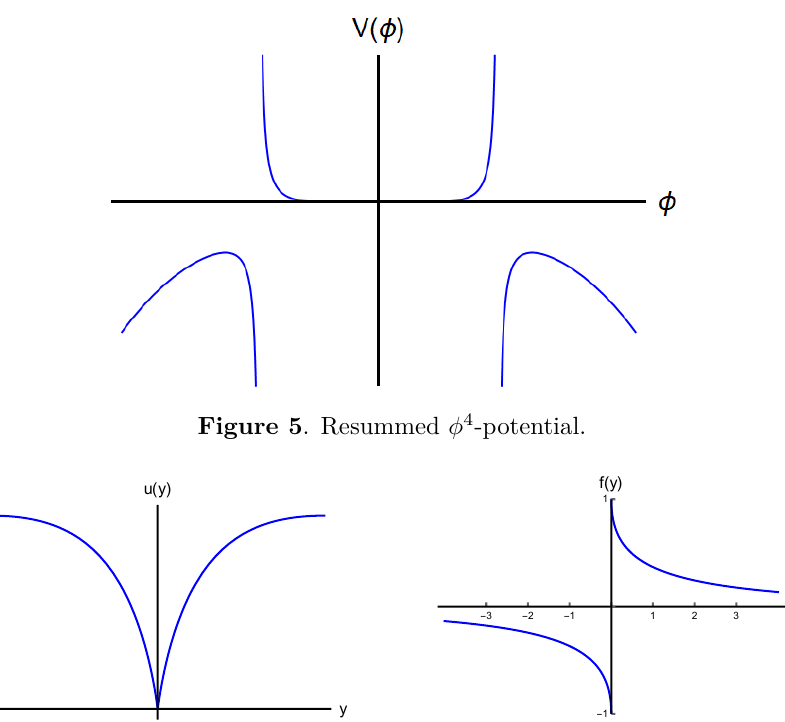
Figure 6 . Qualitative behaviour of the functions u ( y ) (left) and f ( y )